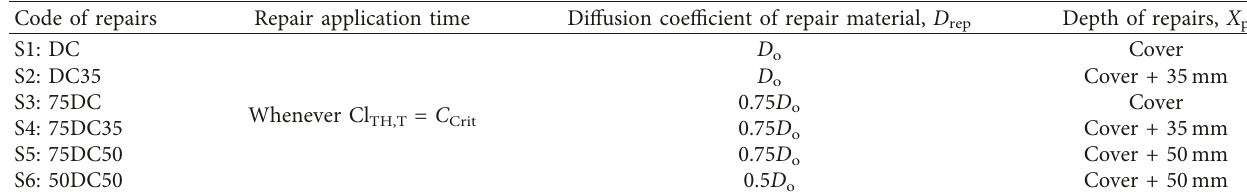
Table 2: Six proposed repair strategies for corrosion-free